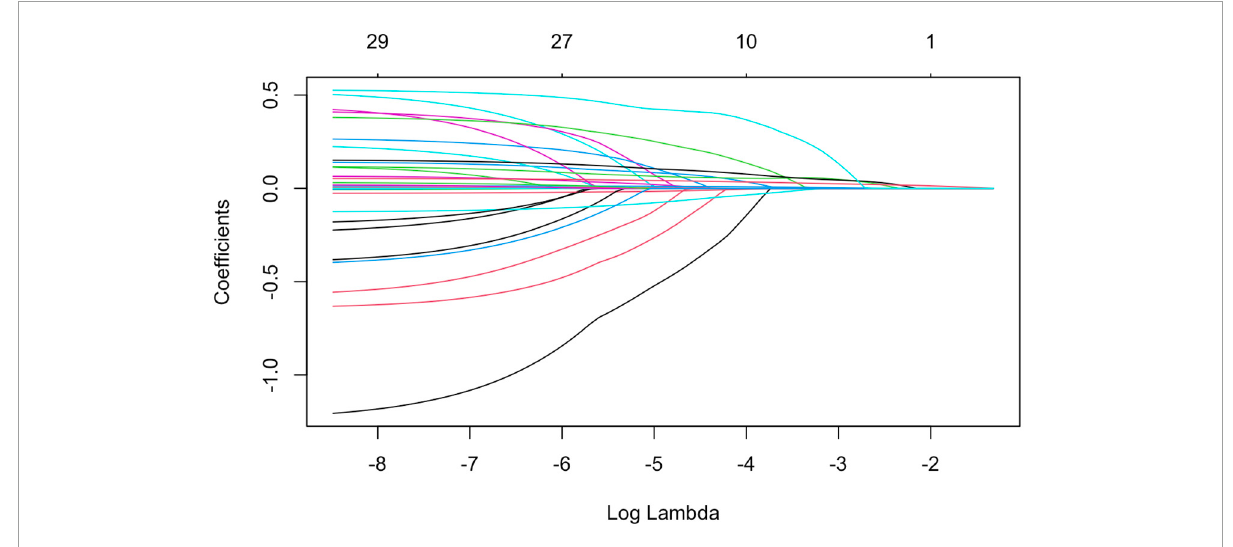
FIGURE2 All variables were screened with LASSO regression.